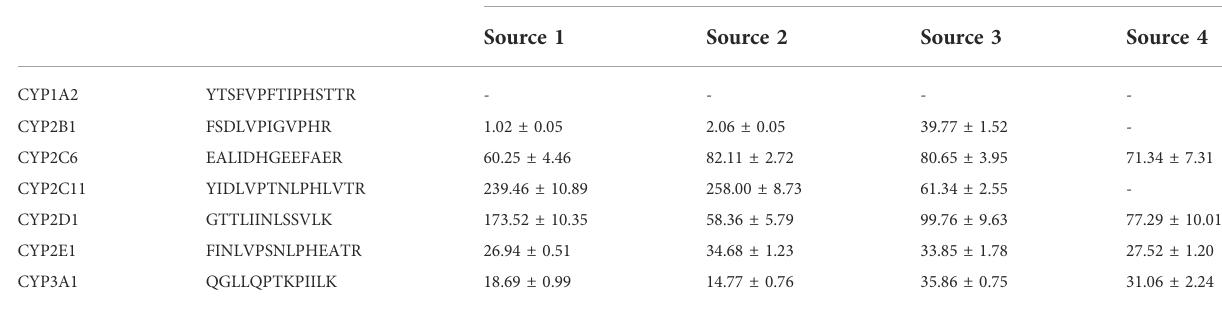
TABLE 5 Protein amounts of CYP enzymes as observed in pooled rat liver microsomes from four sources (IPhase Pharma Services, Corning Gentest, PrimeTox and Meilunbio). Results are expressed as concentration (Mean ± SD) ( n = 4).